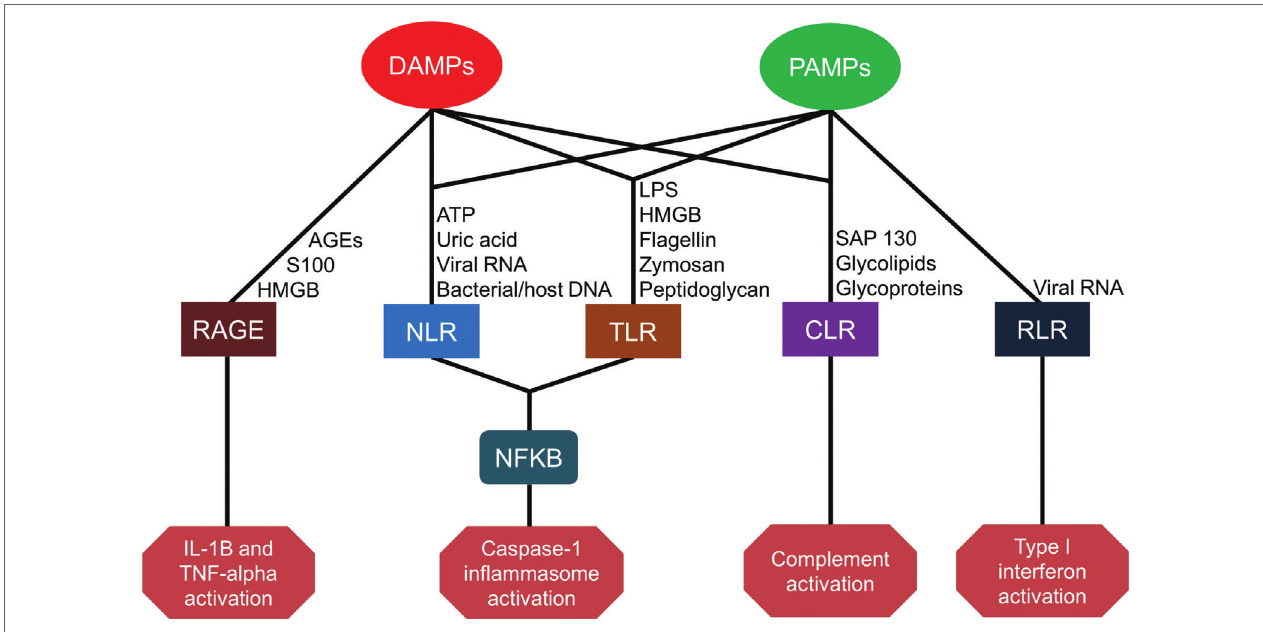
FiGURe 1 | Pattern-recognition receptor pathways for damage-associated molecular patterns (DAMPs) and pathogen-associated molecular patterns (PAMPs). AGEs, advanced glycosylation end products; HMGB, high-mobility group box; ATP, adenosine triphosphate; RNA, ribonucleic acid; DNA, deoxyribonucleic acid; LPS, lipopolysaccharide; RAGE, receptor for advanced glycation end products; NLR, nucleotide-binding oligomerization domain-like receptors; TLR, toll-like receptors; CLR, C-type lectin receptors; RLR, retinoic-acid-inducible gene-I-like receptors; NF-kB, nuclear factor kappa-light-chain-enhancer of activated B cells; IL, interleukin; TNF, tumor necrosis